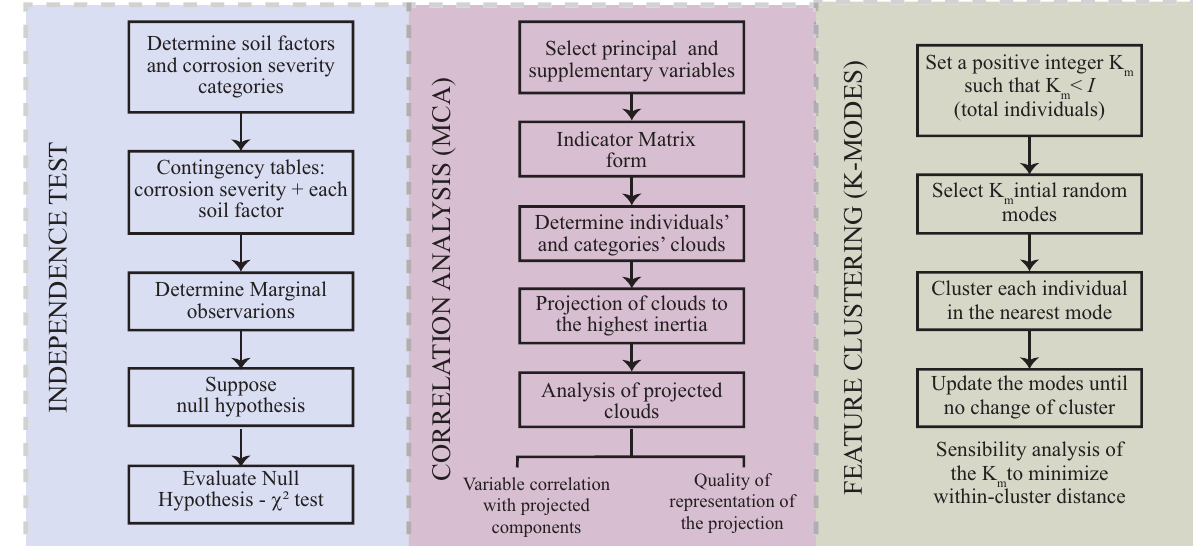
Figure 4. Scheme of the proposed methodology. MCA: multiple correspondence